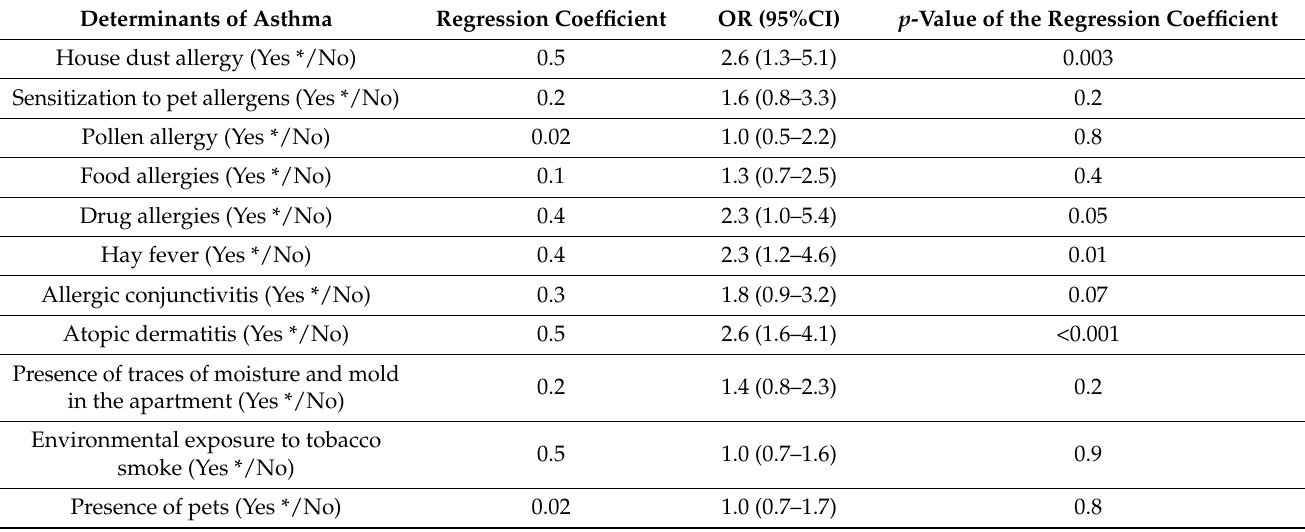
Table 6. Crude odds ratios (OR) and 95% confidence intervals related to determinants of observed respiratory